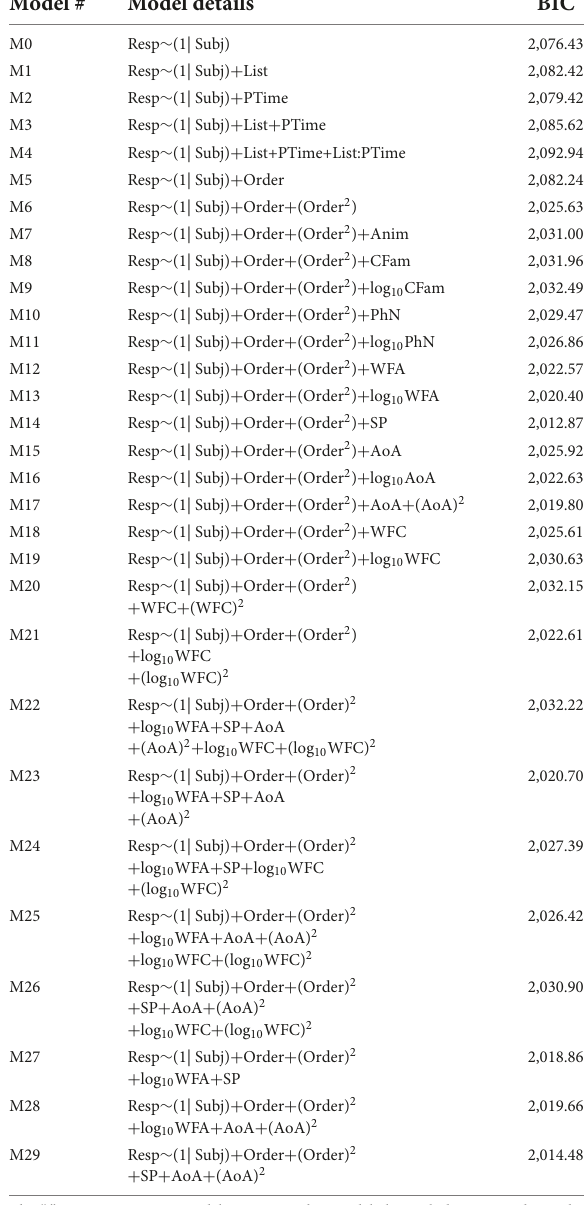
TABLE 4 Models and model fit (BIC) to the data of Experiment